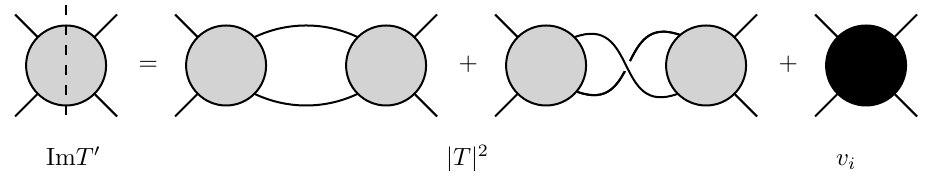
Figure 12 . Graphical depiction of the fixed-point mapping action. In the r.h.s. we included the contributions of both the s and u -channel as required by crossing. On a given unitarity cut, s > 4 or s < 0 , only one of them